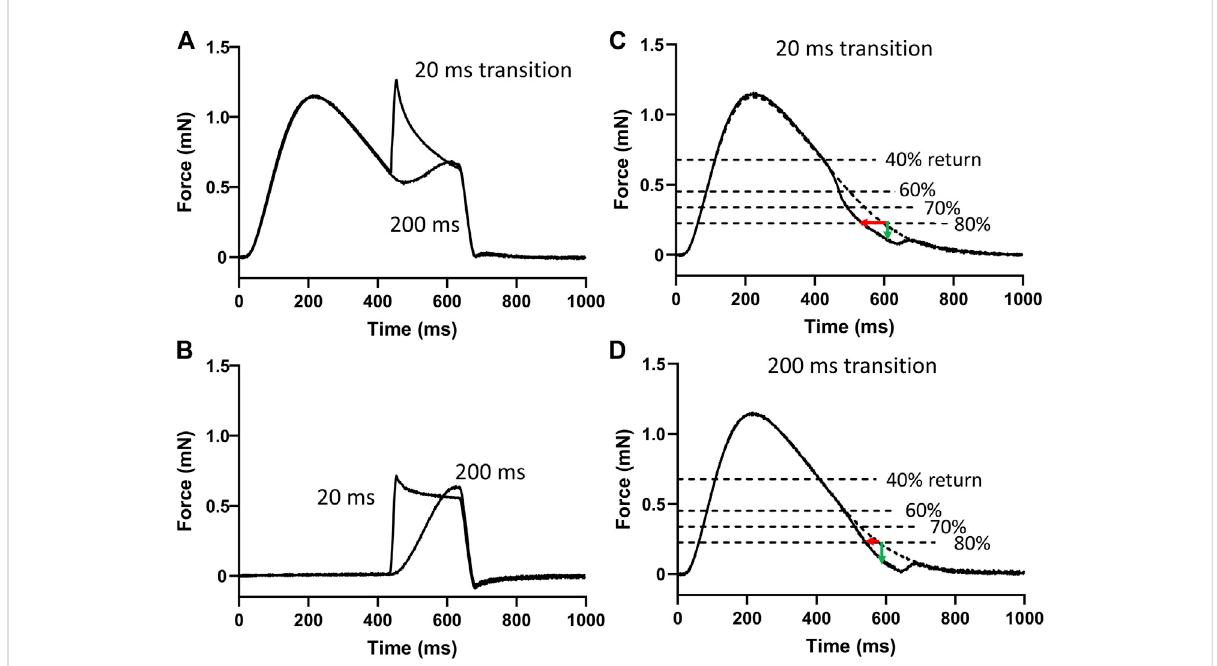
FIGURE 3 Analysis of myo fi lament response to stretch. (A) Two of the 20 force responses recorded during stimulation are overlayed here and represent the force responses of the myo fi laments and the passive components during the 20 and 200 ms stretches. (B) The corresponding two force responses recorded without stimulation represent the passive components. These responses without stimulation were subtracted from those with stimulation to provide the myo fi lament response to stretch. (C) An example myo fi lament response to a 20 ms duration stretch to 1% muscle length. Times to 40%, 60%, 70%, and 80% return were detected. The effects of stretch on shortening of these times (red arrow) and on the loss of force at these times (green arrow) relative to the pre-stretch transient were detected. (D) An example myo fi lament response to a 200 ms duration stretch to 1% muscle